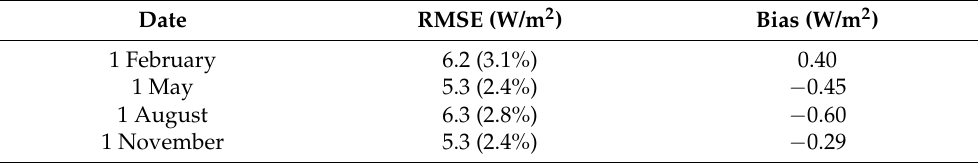
Table 3. RMSE and Bias of the estimated daily AHI OLR on four selected days in 2017.